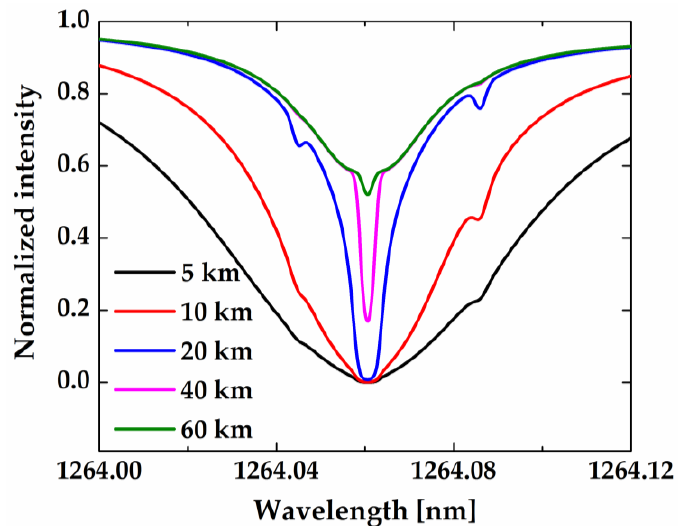
Figure 12. Variation in the absorption line shape with tangent heights. The line shape is broad at lower tangent heights of 5 and 10 km and becomes a superposition of a narrow component and a much broader one above 20 km.